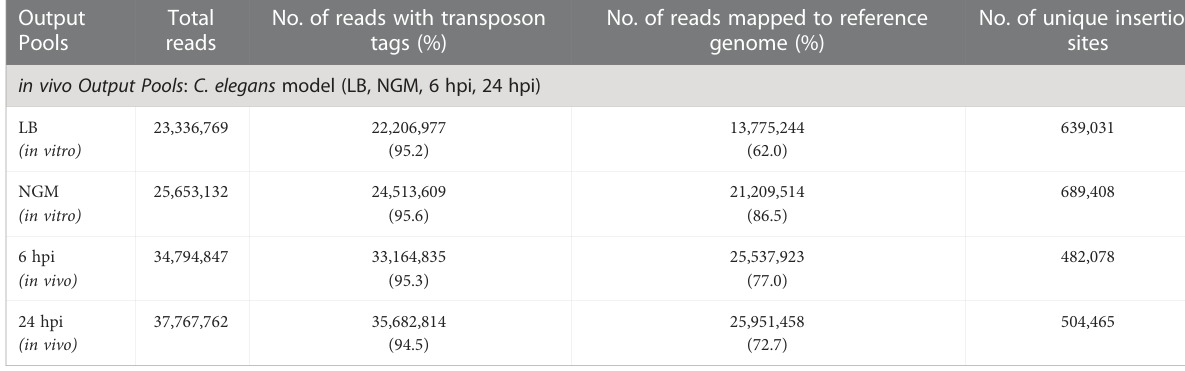
TABLE 2 Summary of TraDIS results from B. pseudomallei in vivo output